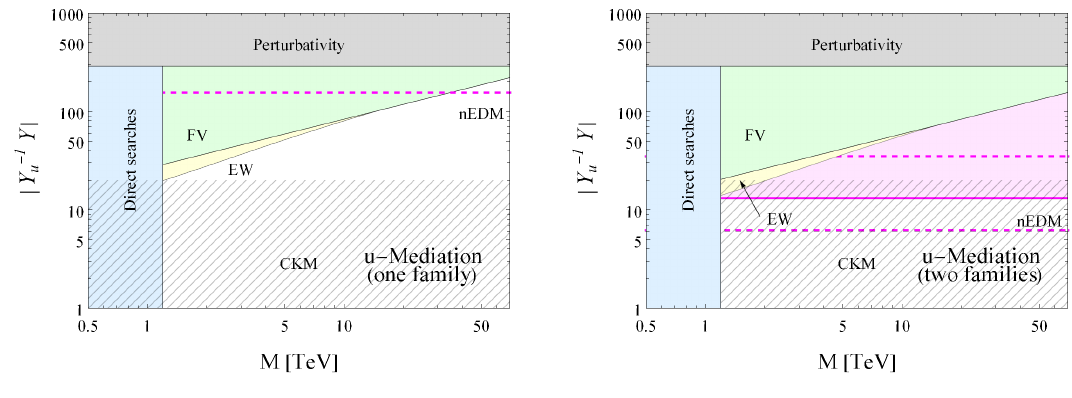
Figure 3 . Summary of the most relevant experimental constraints on models of u -mediation with one (left) or two (right) families of ψ, ψ c . To reproduce the CKM we imposed the structure (3.2). We show direct searches in light blue, electroweak in yellow (“EW”, see (3.9)), flavor violation in light green (“FV”, from B s − B s mixing), the neutron electric dipole moment (“nEDM”) in magenta. The lower and upper bounds from section 2.1.1 are identified by the hatching and the grey region. See the text for